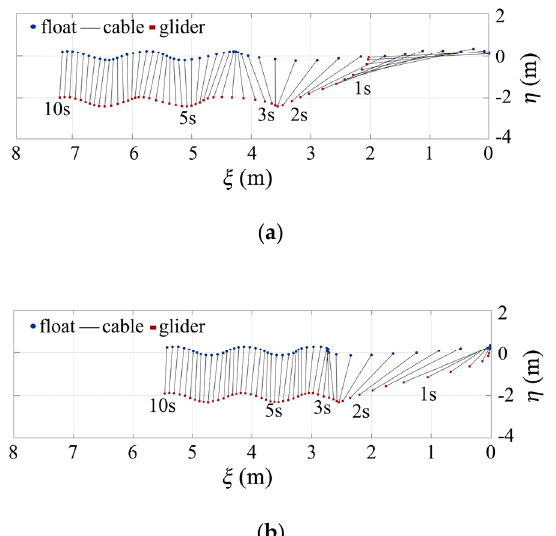
Figure 8. Motion trajectory of a wave glider during the process of deployment of ( a ) Method 1 and ( b ) Method 2.